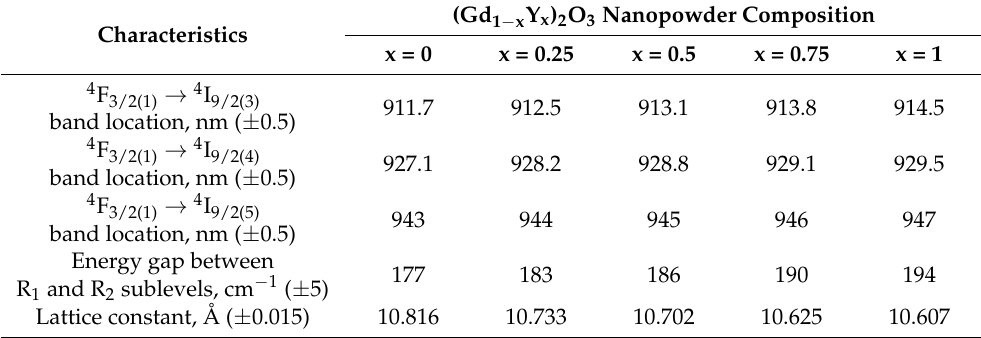
Table 3. Influence of (Gd 1 − x Y x ) 2 O 3 composition on the luminescent transitions’ location and crystal lattice